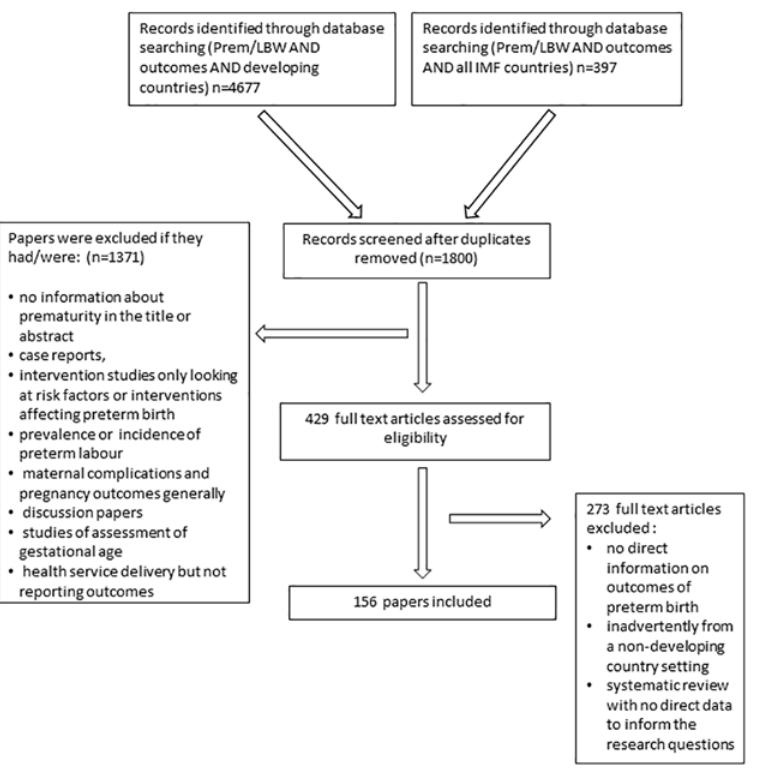
Fig 1. PRISMA Diagram.